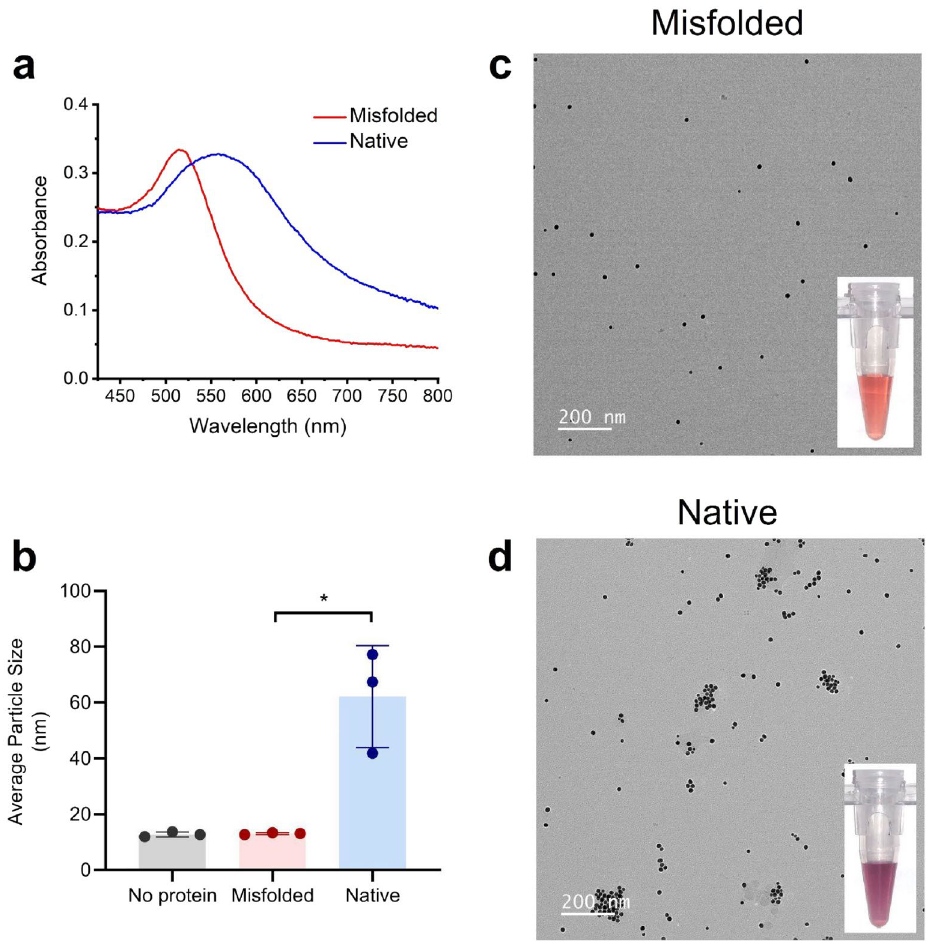
Figure 2. Mechanism of AuNP solution color shift. ( a ) The absorbance spectrum of AuNP solutions spiked with misfolded rPrP from seeded QuIC reactions (red line) and native (non-misfolded) rPrP from QuIC reactions without seed (blue line). ( b ) Average effective particle sizes in AuNP solutions containing no protein, misfolded rPrP, and native rPrP observed by DLS. ( c ) TEM image of 15 nm AuNPs after being spiked with post amplified misfolded PrP. Inset shows an example of AuNP solution after being spiked with misfolded PrP. ( d ) TEM image of aggregating AuNPs after being spiked with native PrP. Inset shows an example of AuNP solution after being spiked with post amplified native PrP. *, p-value < 0.05, error bars show standard